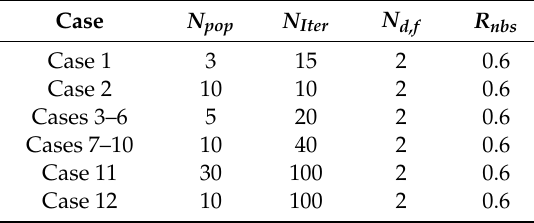
Table 2. The selection of population size and the highest iteration